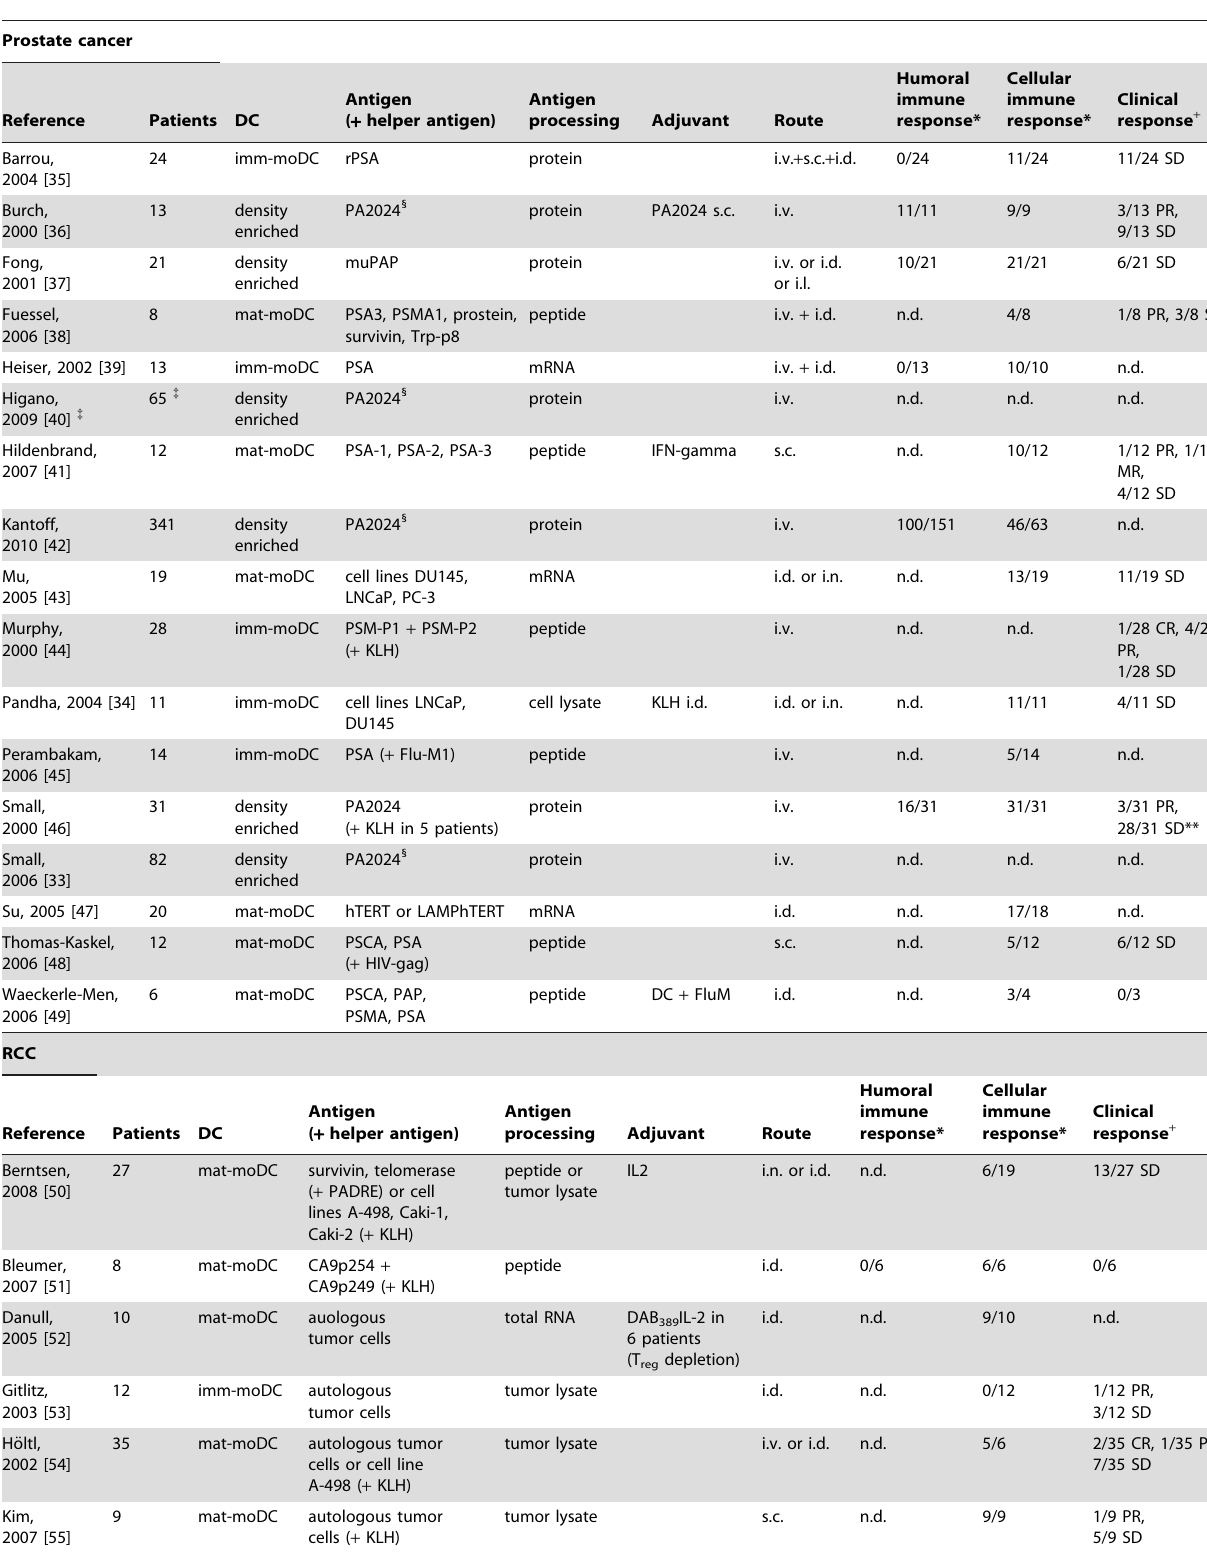
Table 1. Clinical trials with DC based tumor vaccination in prostate cancer and RCC.